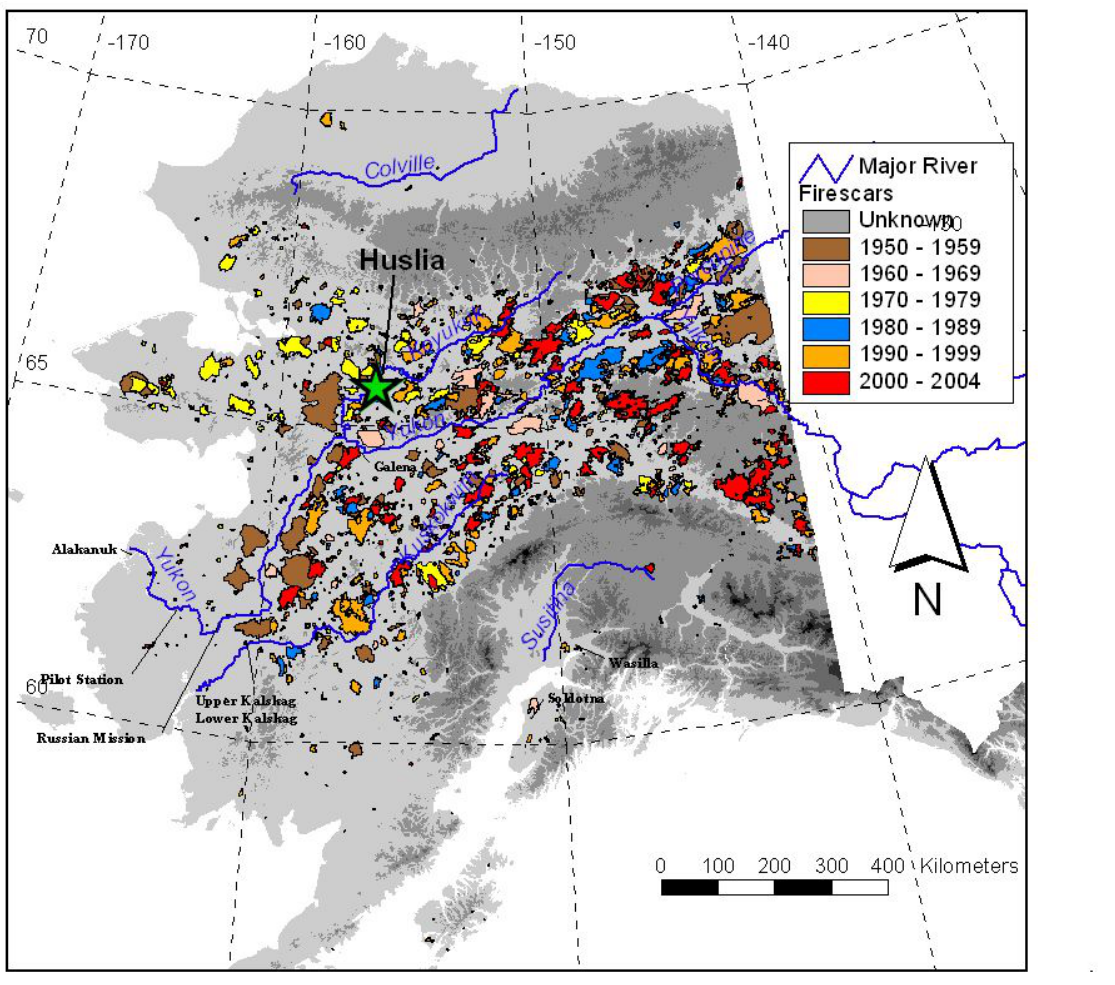
Fig. 1. Map of fire history in interior Alaska showing the location of the the village of